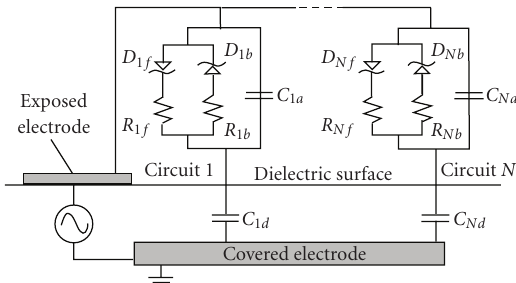
Figure 4: Electric circuits used to compute the properties on the dielectric surface (only circuits 1 and N are shown) [19,